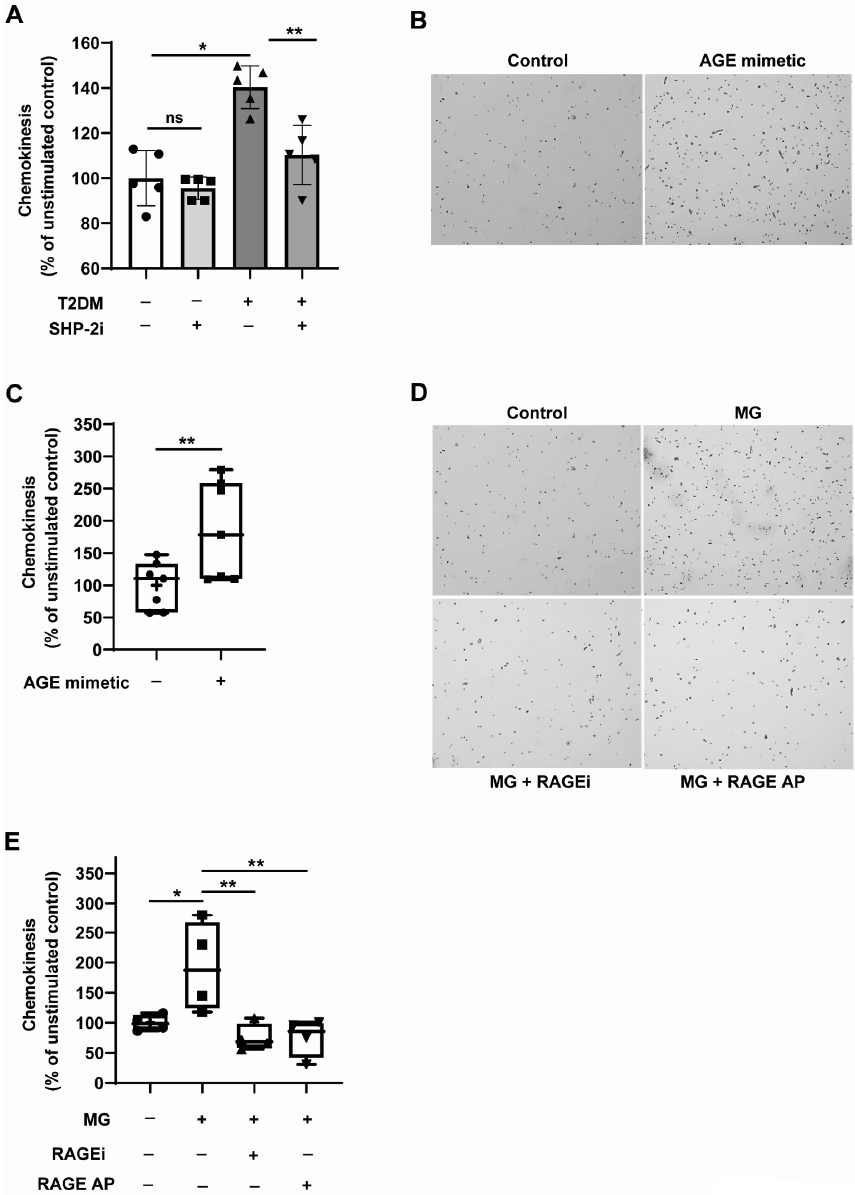
Figure 5. RAGE ligation accelerates and RAGE inhibition attenuates the MG-induced random motility of monocytes. ( A ) Random motility analysis of monocytes from T2DM patients. Primary monocytes isolated from the peripheral blood of non-T2DM ( n = 5) and T2DM ( n = 5) were treated with 400 nM of the SHP-2i (NSC 878777) for 8 h. After that, the monocytes were analysed for their migratory potential using Boyden chamber assays. ( B ) Representative pictures of automatically counted monocytes that migrated completely through the membrane during transwell migration and ( C ) corresponding quantification. Circles (Control) and squares (exposure with 150 µ g/mL AGE-BSA for 24 h) represent counted monocytes of each experiment in percentage compared to the mean value of unstimulated control. n = 7. ( D ) Representative pictures of automatically counted monocytes which migrated completely through the membrane during transwell migration and ( E ) corresponding quantification. Circles (Control) represent untreated counted monocytes of each experiment in percentage compared to the mean value of unstimulated control. Other samples were treated with 300 µ M MG for 24 h. Squares indicate monocytes with functional RAGE. Triangles show monocytes treated either with RAGE-inhibitor (aligned upwards) or RAGE antagonist peptide (aligned downwards). n = 4. * p < 0.05, ** p <